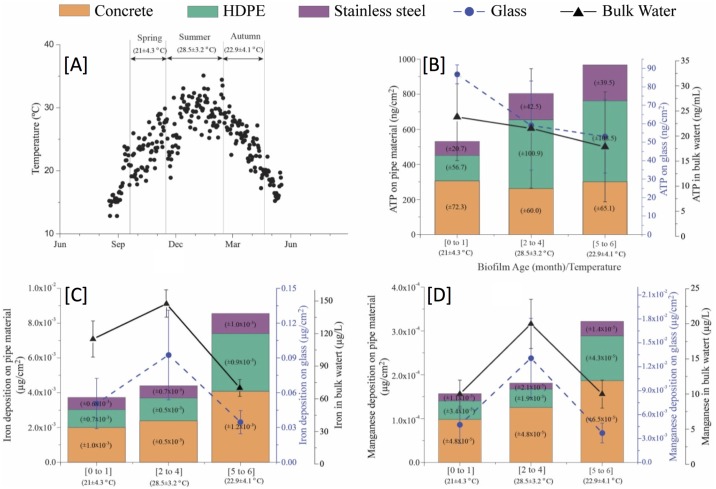
Details of monitored parameters during the study period.2[A]: Bulk water temperature profile of entire study period. 2[B]: The live biomass (measured as a concentration of ATP) attached to different material and suspended in bulk water. 2[C]: The iron deposited on material and suspended in bulk water. 2[D]: The manganese deposited on material and suspended in bulk water. (± denotes the standard deviation)